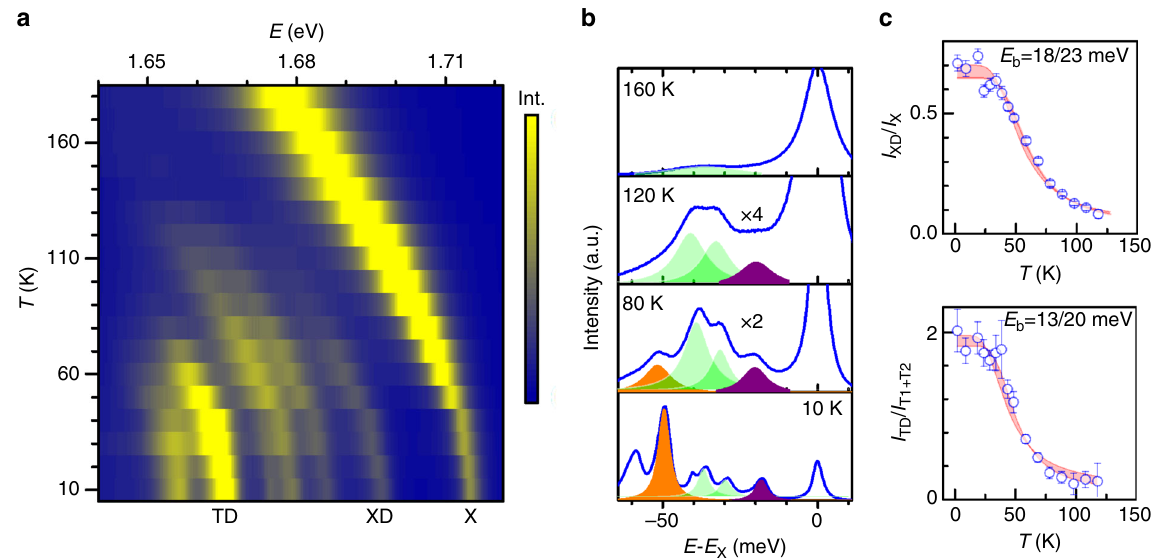
Fig. 3 Temperature dependence of the excitonic emission. a Color map of PL spectra for temperatures ranging from 4 to 180 K. b Selected spectra at different temperatures showing the evolution of XD (purple) and TD (orange) emissions. c The normalized intensity of XD and TD plotted as a function of temperature. The decrease of intensity reveals the thermally activated dissociation as determined by the binding